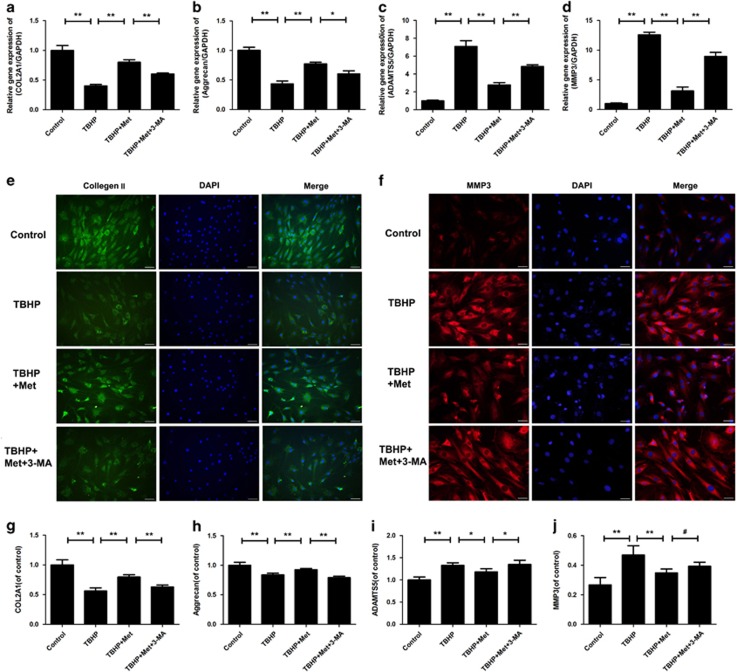
Effects of metformin on degeneration-related genes and protein expression in nucleus pulposus cells induced by oxidative stress. (a–d)The mRNA expression of Col2a1, Aggrecan, Adamts-5 and Mmp-3 were measured by real-time PCR. Gene expression was normalized by individual GAPDH expression, and expressed as mean of fold-change mean±S.D. compared with control level. (e–f) The representative collagen-II and Mmp3 were detected by the immunofluorescence combined with DAPI staining for nuclei (collagen-II: original magnification × 200, scale bar: 50 μm, Mmp3: × 400, scale bar: 25 μm). (g–j)The expression of Col2a1, Aggrecan, Adamts-5 and Mmp-3 were measured by ELISA. The data in the figures represent the averages±S.D. Significant differences between the treatment and control groups are indicated as **P<0.01, *P<0.05, #P>0.05, n=3